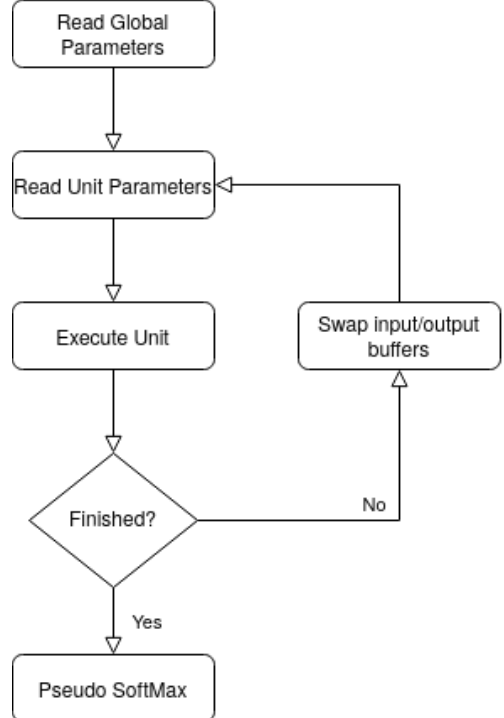
Figure 2. High-level workflow of the